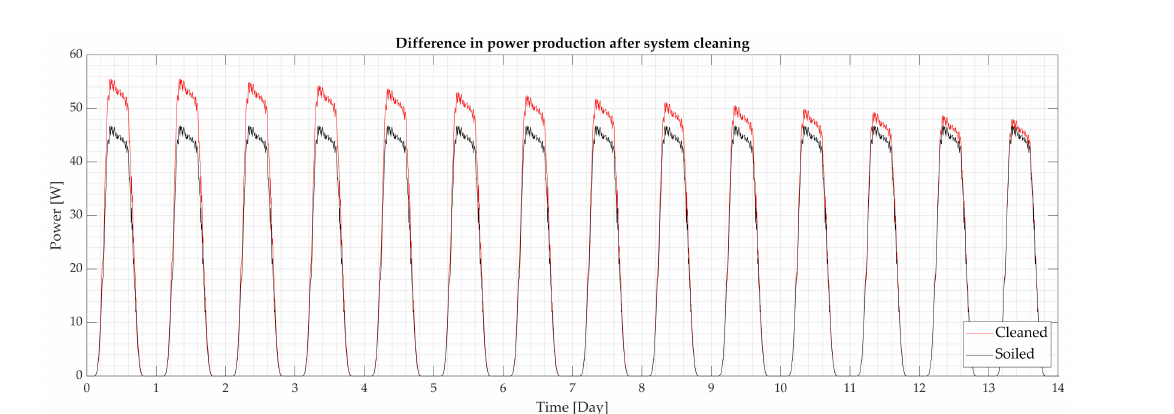
Figure 9. Power from PV over 14 days for soiled and clean